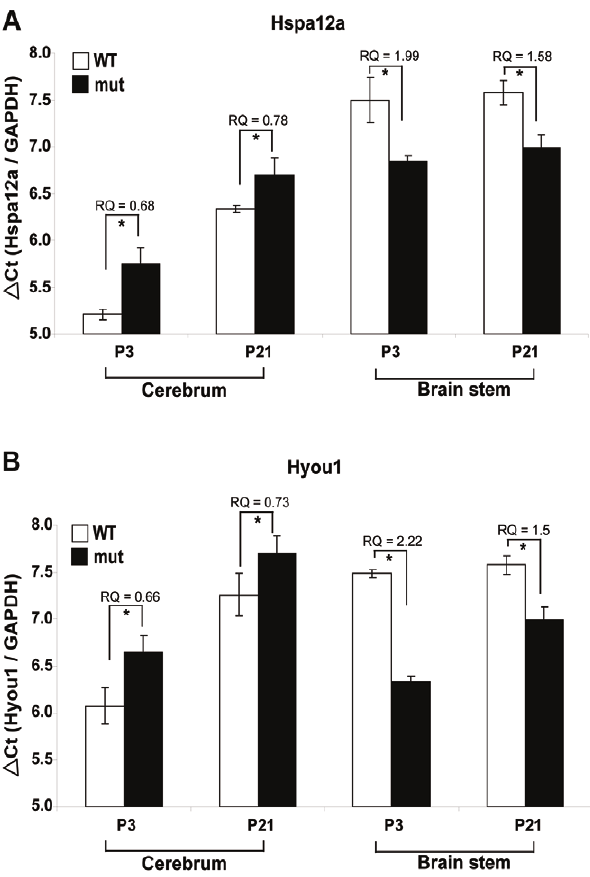
Figure 5. qRT-PCR of Hspa12a and Hyou1 in different brain regions. RNA was isolated from the cerebrum or brain stem of wild type (WT) and mutated (mut) mice at P3 and P21 followed by qRT-PCR analysis using primers specific for Hspa12a (A) and Hyou1 (B). Each mRNA expression level shown is the average of 3 biological samples calculated relative to GAPDH control. Data are presented as D Ct (gene of interest/GAPDH). High D Ct value indicates low mRNA level. The calculated relative quantity (RQ) in mut relative to WT is shown for each case; * indicates p , 0.05.